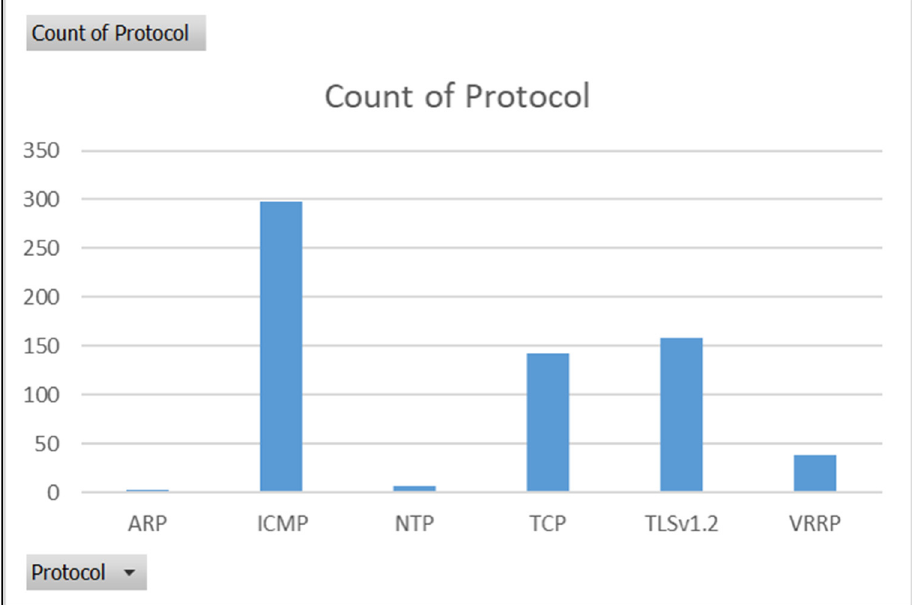
Figure 16. Protocols from pfSense extracted from pfSense.